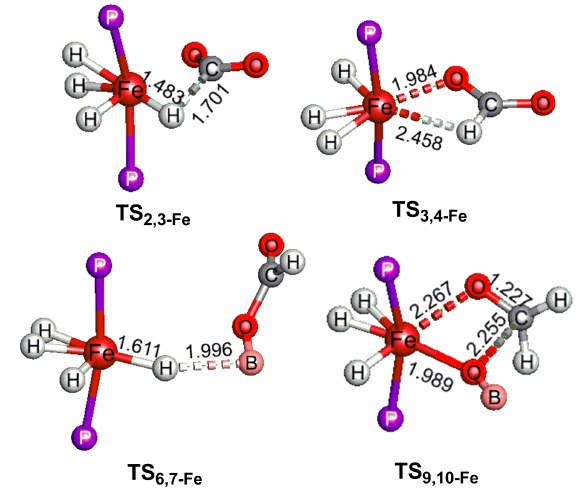
Figure 4. Optimized structures of TS 2,3 ‐ Fe (460 i cm − 1 ), TS 3,4 ‐ Fe (78 i cm − 1 ), TS 6,7 ‐ Fe (191 i cm − 1 ) and TS 9,10 ‐ Fe (86 i cm − 1 ). Bond lengths are in Å. The cyclopentyl and pinacol groups are not shown for clarity.